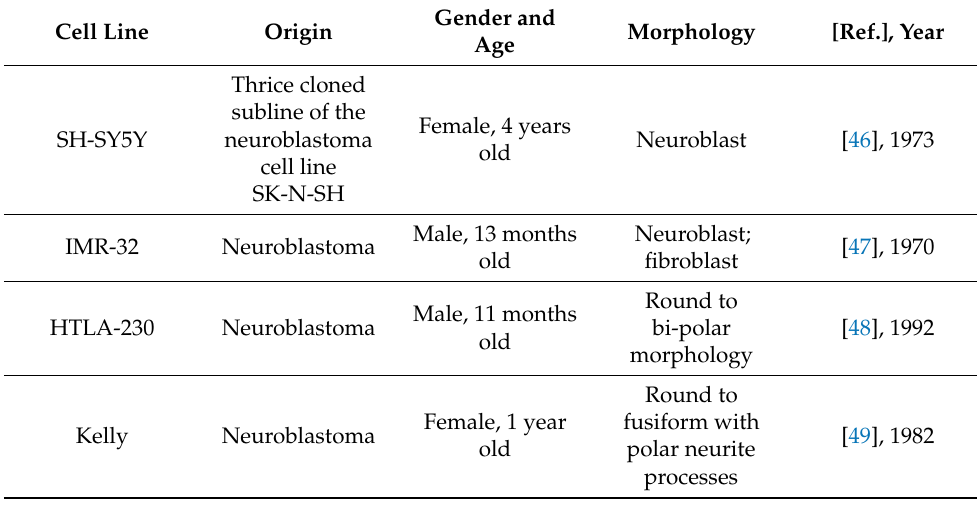
Table 3. Characteristics of neuroblastoma-derived cell lines and year first cited.